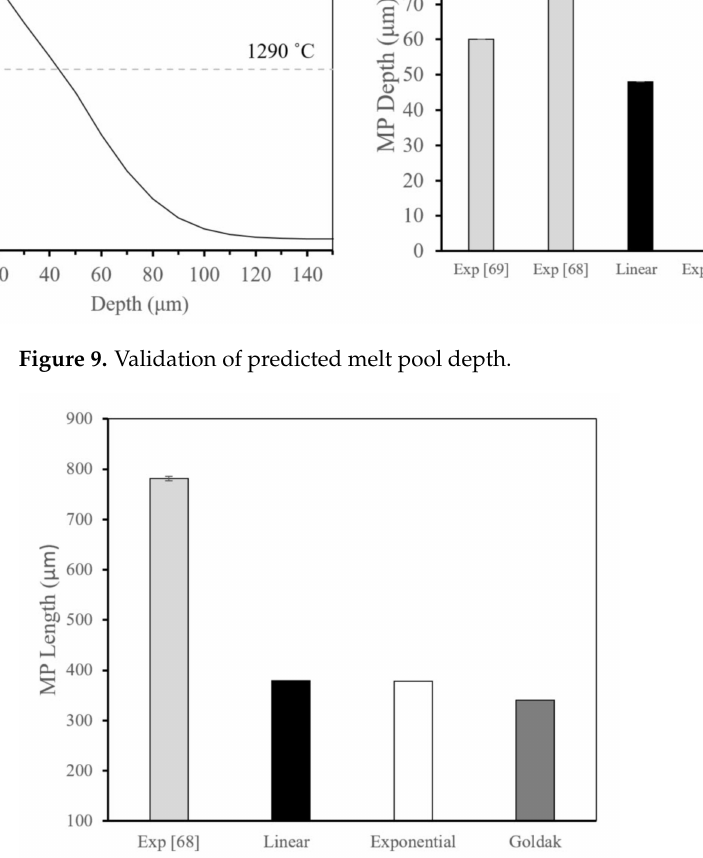
Figure 10. Melt pool length prediction for different heat source